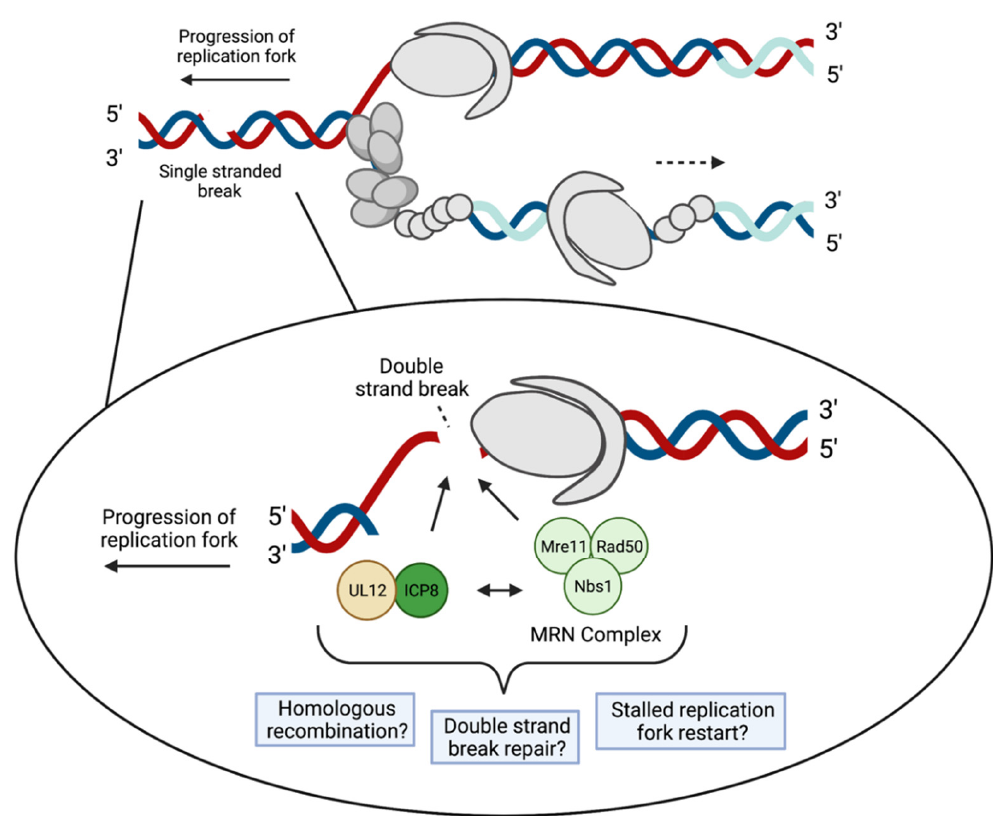
Figure 4. Potential role of the MRN complex in HSV-1 DNA replication. As the HSV-1 replication fork progresses, the viral polymerase UL30 may encounter single-strand breaks and gaps on the DNA. UL30 is then unable to continue synthesizing the new DNA strand, resulting in a double-strand break. Perhaps the MRN complex (light green) and the two subunit recombinase—UL12 (yellow) and ICP8 (dark green)—function together for double-strand break repair via homologous recombination to enable stalled replication fork restart. Inside the circle is a zoomed in image of what may occur at a single-strand break as the replication fork progresses on the leading strand. Created with BioRender.com, accessed on 28 September 2021.